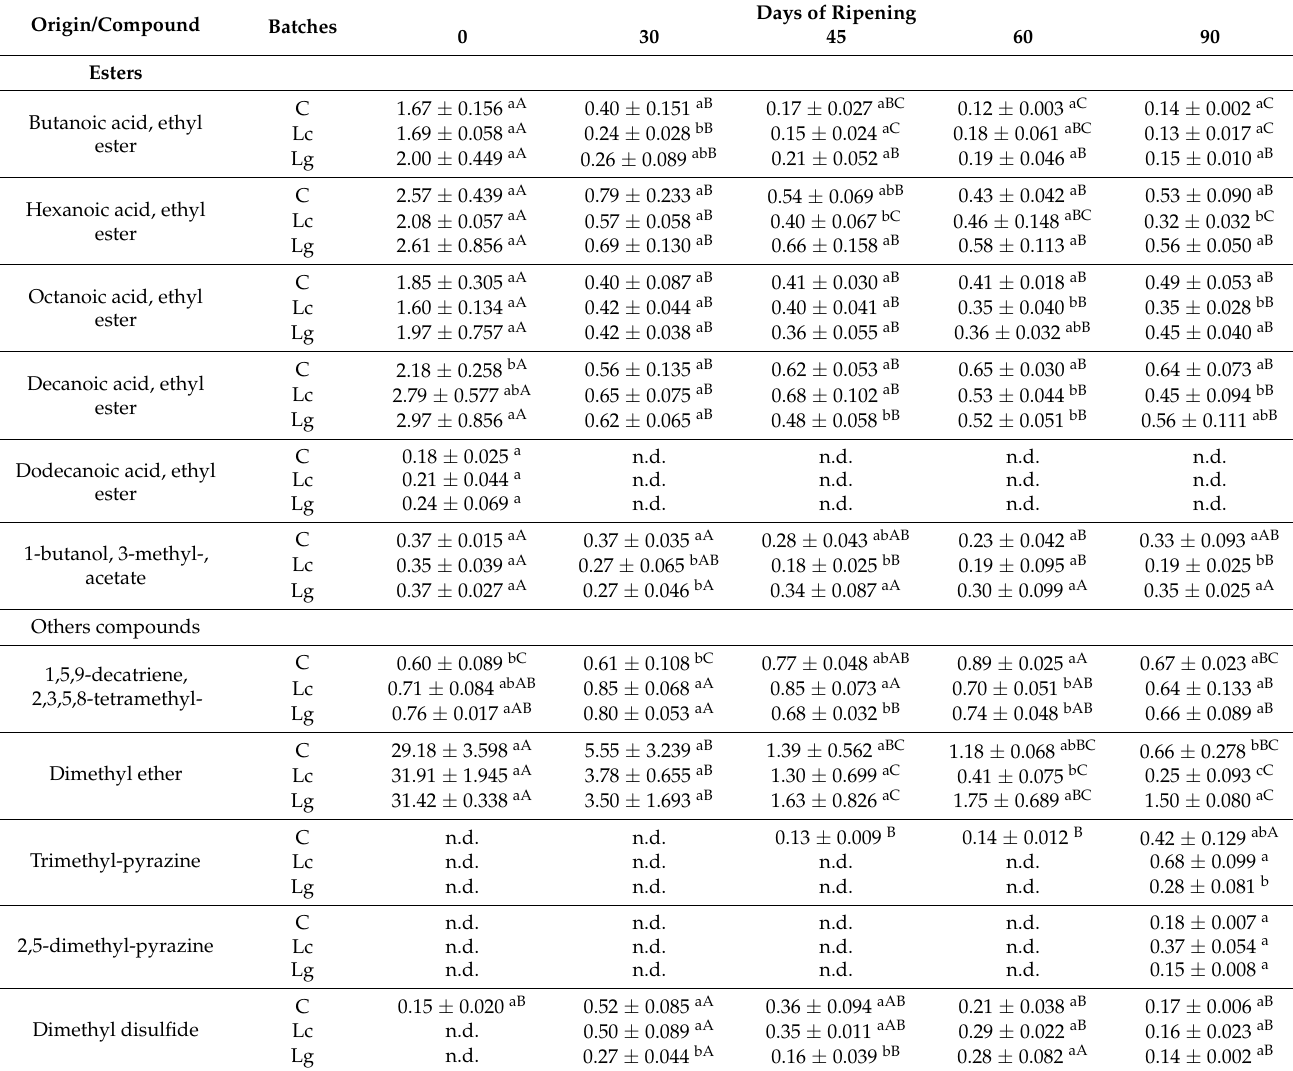
Table 4. Esters and others volatile compounds (AU × 10 6 ) of “Torta del Casar” cheese during the